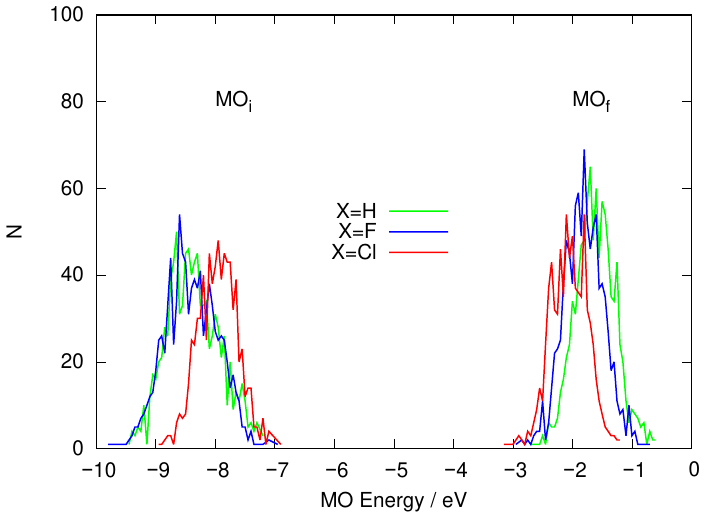
Figure 7. Distribution of the energy of the MOs involved in the excitation that gives rise to S 1 taken from the snapshots from the QM/MM molecular dynamics simulation where the solute is described using DFTB. MO i (left) denotes the orbital where the excitation starts and MO f (right) the orbital where the excitation